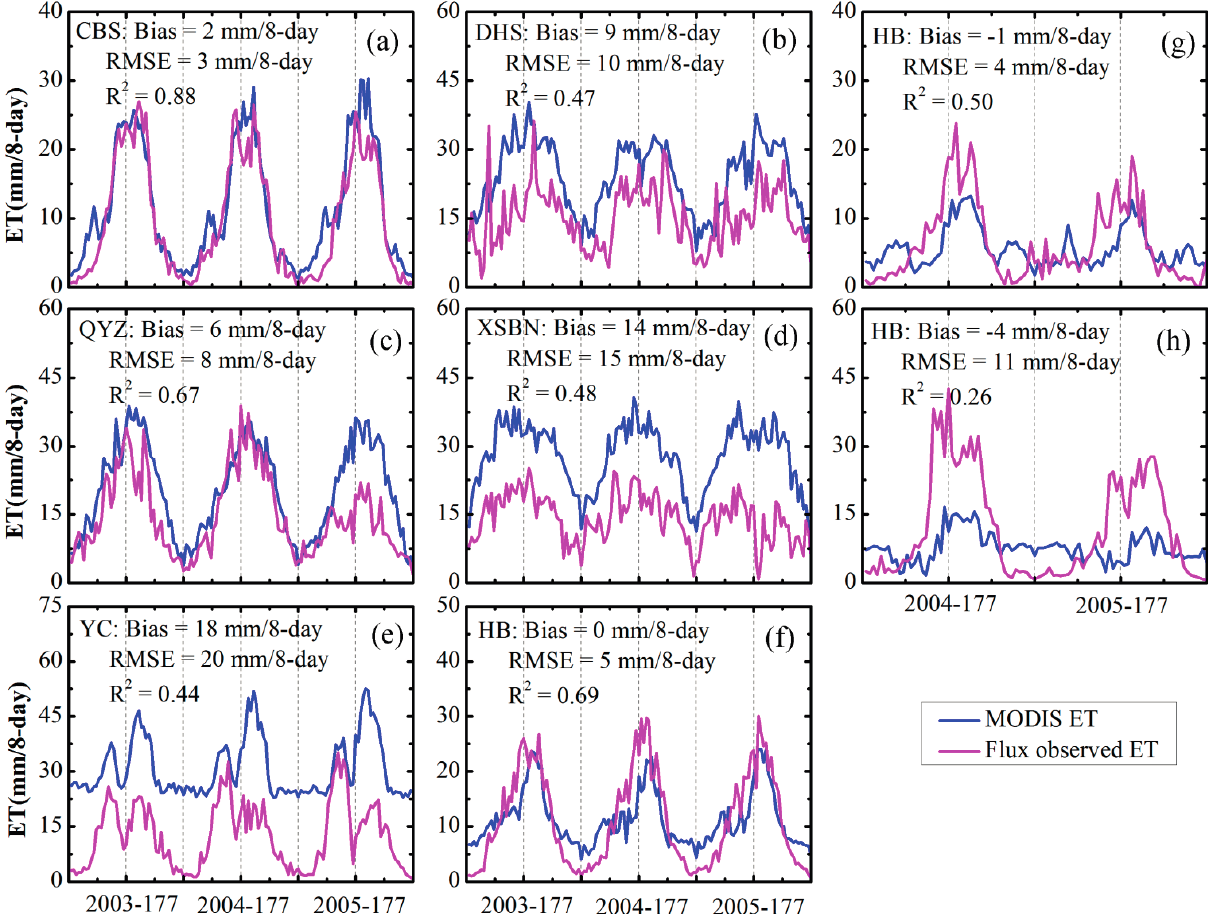
Figure 3. Comparison between the flux observed ET and MODIS-ET for all sites, pink solid line and blue solid line represent the flux observation ET and MODIS-ET, respectively. (DOY: Day of year). ( a ) in mixed forests site; ( b ) in evergreen broadleaf forests site; ( c ) in evergreen needleleaf forests site; ( d ) in evergreen broadleaf forests site ( e ) in croplands; ( f,g , h ) in grasslands